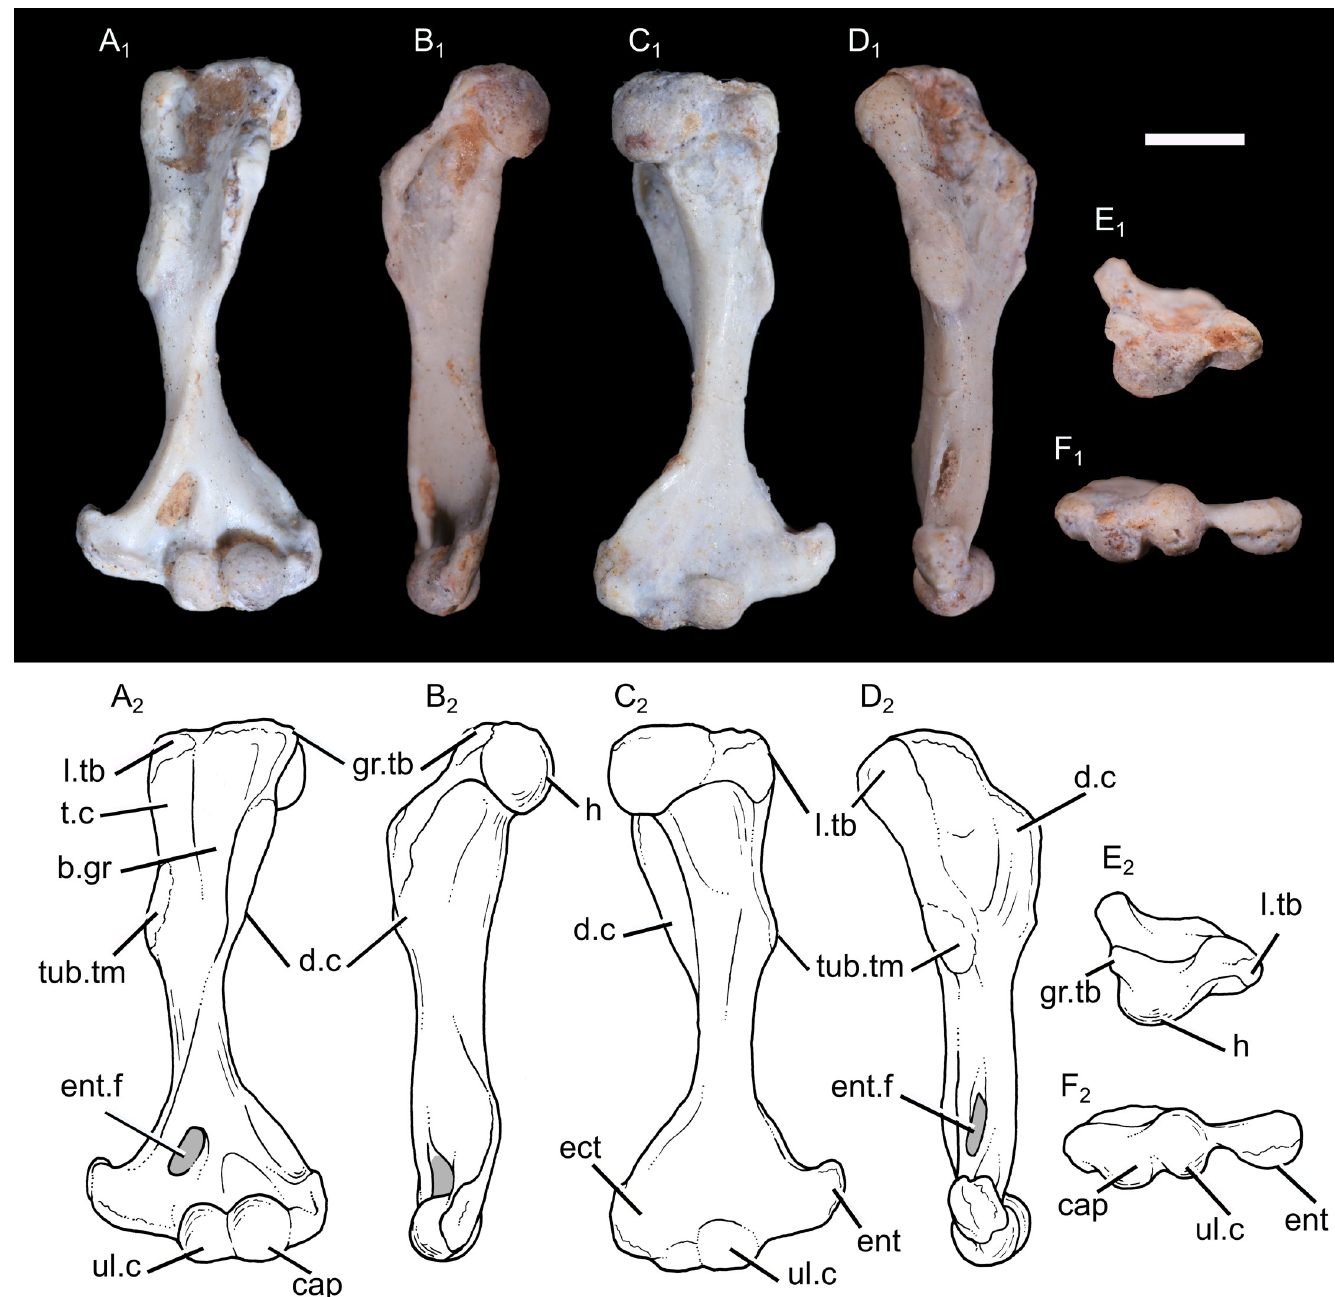
Fig 3. Photography (1) and drawing (2) of the left humerus of Brasilodon quadrangularis (UFRGS-PV-1043-T). A , in anterior view; B , in lateral view; C , in posterior view; D , in medial view; E , in proximal view; F , in distal view. Abbreviations: b.gr , bicipital groove; cap , capitulum; d.c , deltopectoral crest; ect , ectepicondyle; ent , entepicondyle; ent.f , entepicondylar foramen; gr.tb , greater tubercle; h , humeral head; int.gr , intercondylar groove; l.tb , lesser tubercle; t.c , teres crest; tub.tm , tuberosity for the origin of the M . teres major ; ul.c , ulnar condyle. Scale bar = 3 mm.